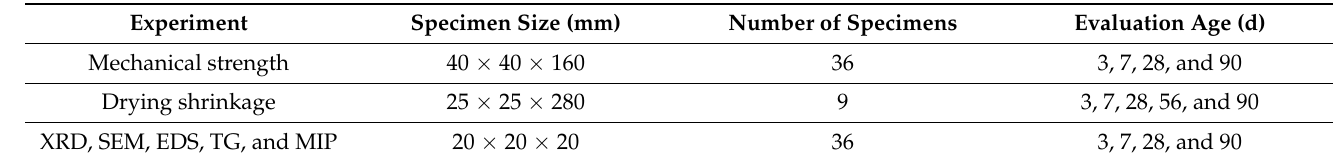
Table 3. Details of the specimens used in different